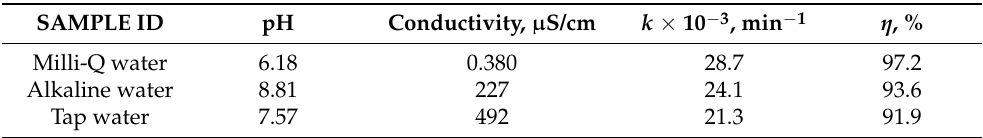
Table 4. The values of the first-order rate constant ( k ) and efficiency ( η ) of RhB dye photodegrada- tion by rGO/TiO 2 /CN nanocomposite photocatalyst, in different water matrix.